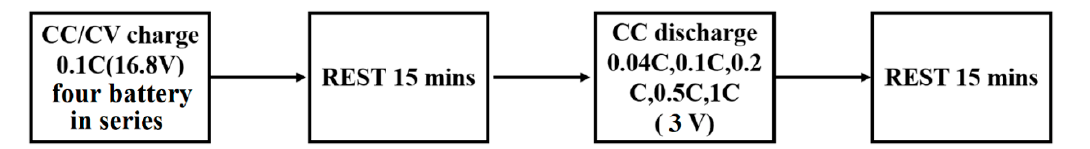
Figure 2. Discharging flowchart (LOOP 300 times).